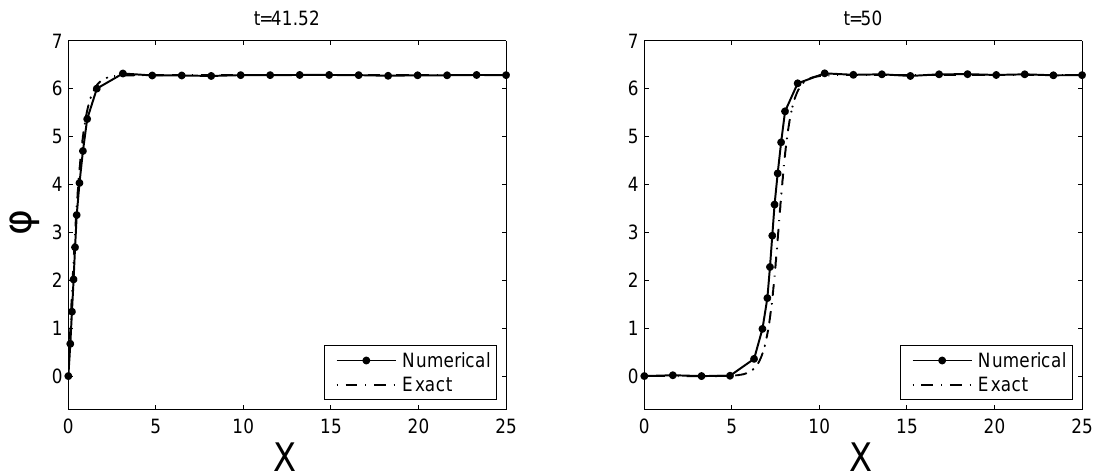
Figure 6. The single soliton solution obtained with the control-theoretic strategy for N = 22: Integration in time was performed using the 4th-order Gauss scheme. Integration with the 4th-order Lobatto IIIA-IIIB yields a very similar level of accuracy.